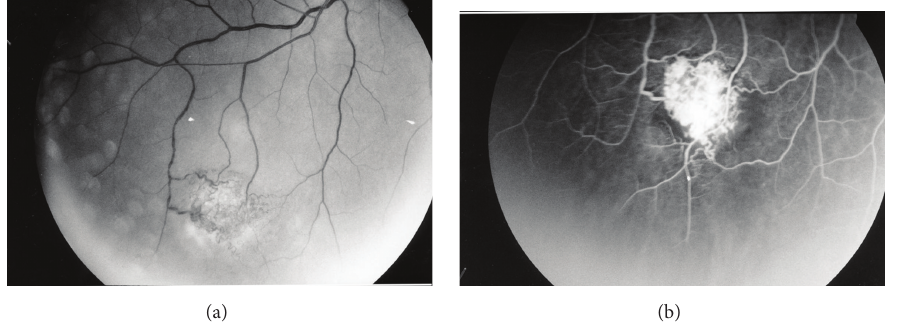
Figure 13: Fluorescein angiography images of a peripheral retinal hemangioblastoma in a patient with Von Hippel-Lindau disease. (a) Early red free image. (b) Late image (from